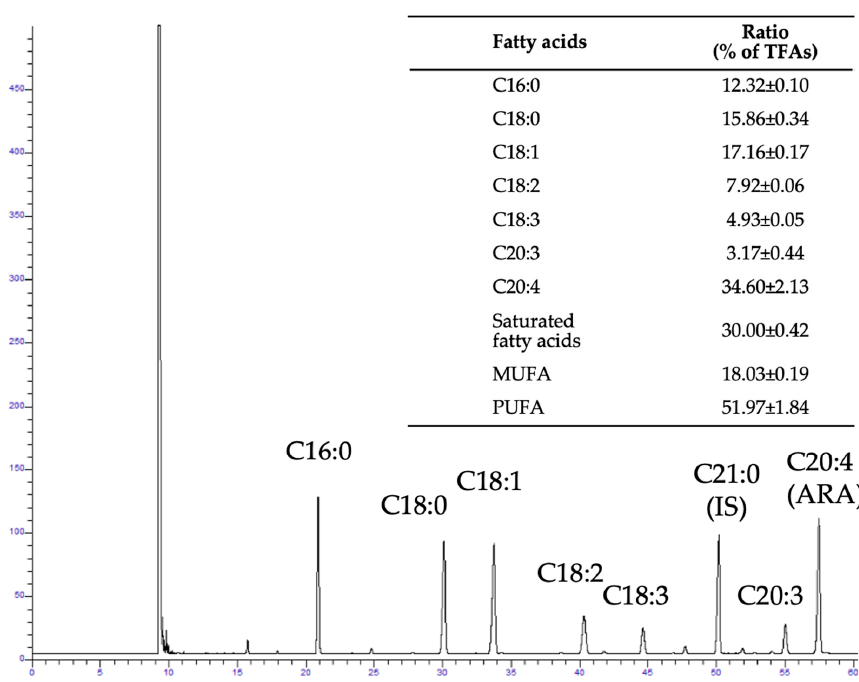
Table 1. Biomass concentration, lipid content, lipid production and ARA ratio of different Mor- tierella alpina strains.